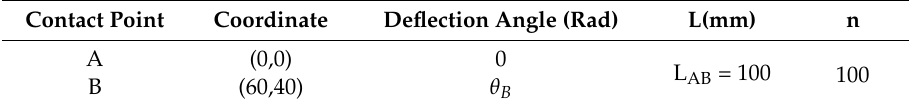
Table 1. Input data for the two-point contact guidewire deformation problem.